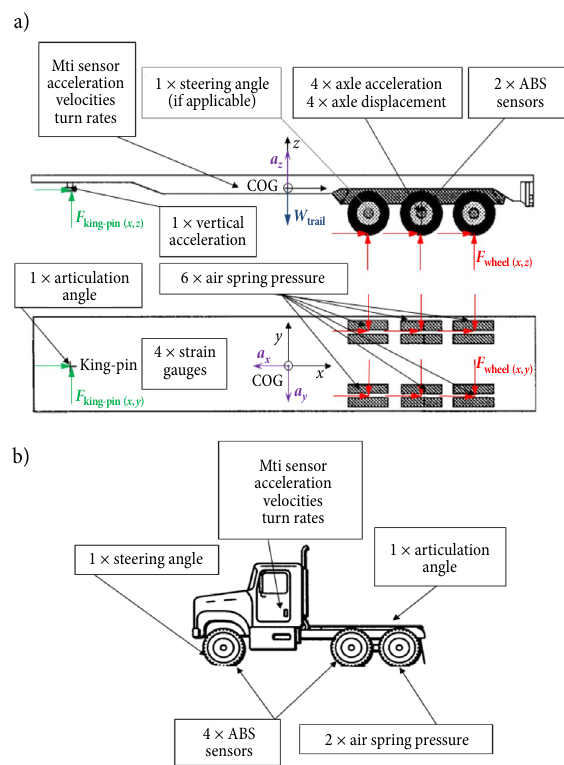
Fig. 2. Instrumentation for: a semitrailer (a) and for a tractor (b)